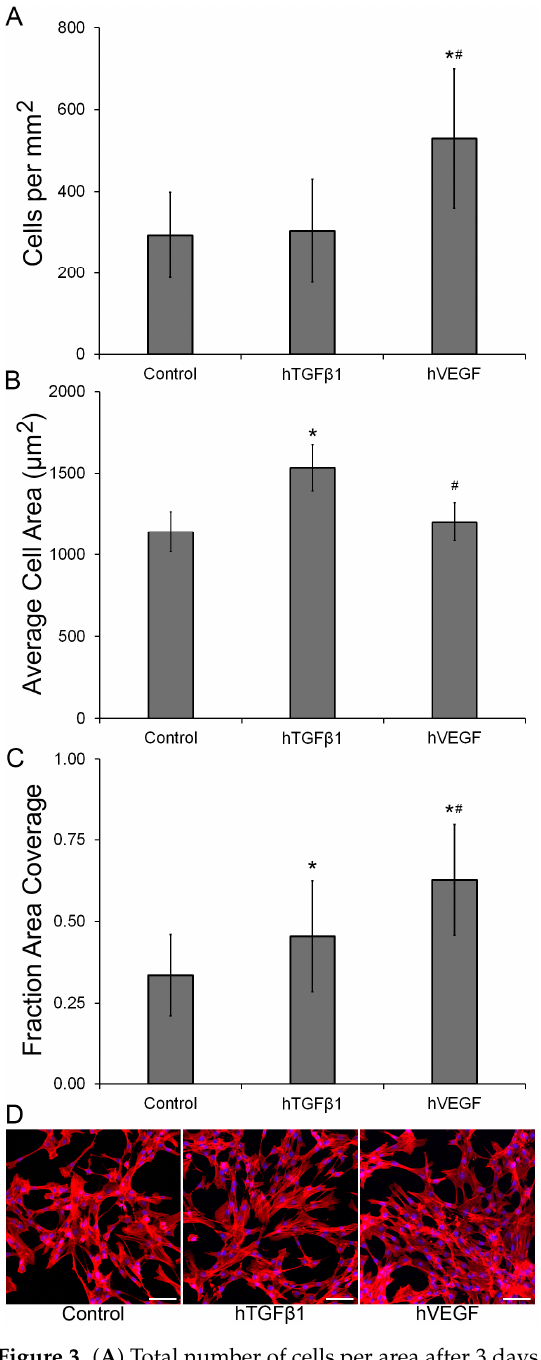
Figure 3. ( A ) Total number of cells per area after 3 days of culture, ( B ) Average cell area, ( C ) Fraction of area covered by HDFa after 3 days of culture, and ( D ) Representative images of HDFa stained with Rhodamine Phalloidin (Red) and DAPI (Blue). The scale bar represents a distance of 100 µm. * Significantly different from control, p < 0.05, # Significantly different from hTGF β 1, p < 0.05. A total of 29 to 36 images were taken from 3 independent specimens per formulation.